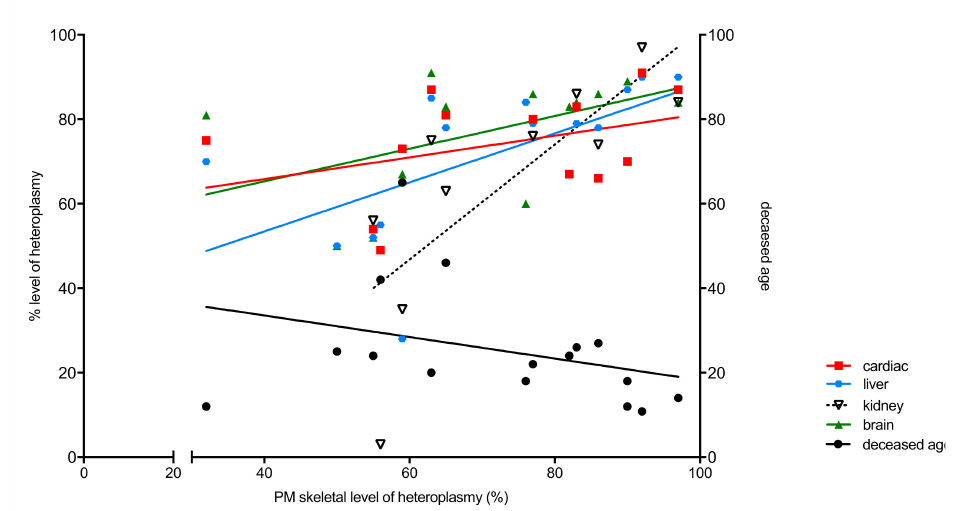
Figure 3. Correlation of heteroplasmy levels (%) in skeletal muscle to levels in cardiac ( p = n.s.), liver ( p = 0.0156), kidney ( p = 0.0100) and brain ( p = n.s.), plotted on the left y-axis. Correlation of heteroplasmy levels (%) in muscle to deceased age ( p = n.s.) is plotted on the right y-axis. n.s.: no significant.